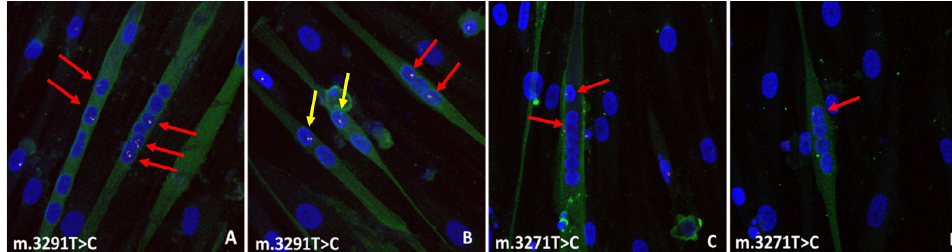
Figure 2. Fusion events between control MABs and MUT1 or MUT2 mutant myotubes. ( A , B ) control MABs fusion with m.3291T>C myotubes (red arrows), and control MABs fusion with MUT2 (m.3291T>C) MABs (yellow arrows) ( C , D ) control MABs fusion with MUT1 (m.3271T>C) myotubes (red arrows).